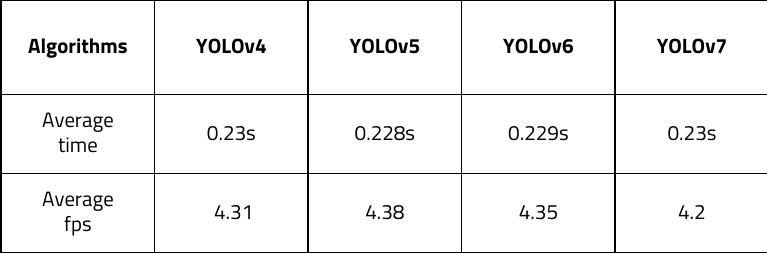
Figure 26. Time and FPS measurement of different versions of